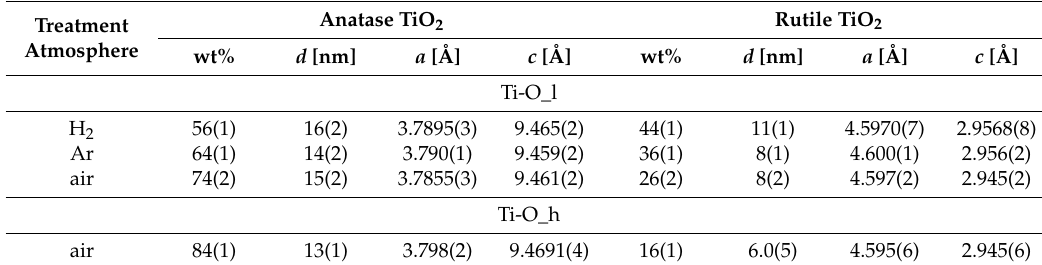
Figure 4. XRD patterns of TiO x NPs samples after a thermal treatment at 400 ◦ C. ( a – c ) sample Ti-O_l in ( a ) H 2 , ( b ) Ar, and ( c ) air; ( d ) sample Ti-O_h in air. The results of Rietveld refinement are reported in Table 4; ( e ) HR-TEM image of sample Ti-O_l treated in air (corresponding to pattern [c]) with the anatase and rutile fringes highlighted in red and green, respectively. Table 4. Quantitative phase analysis for TiO x NPs samples after thermal treatments: rutile vs anatase abundance (wt%), crystallite size d and lattice parameters a and c